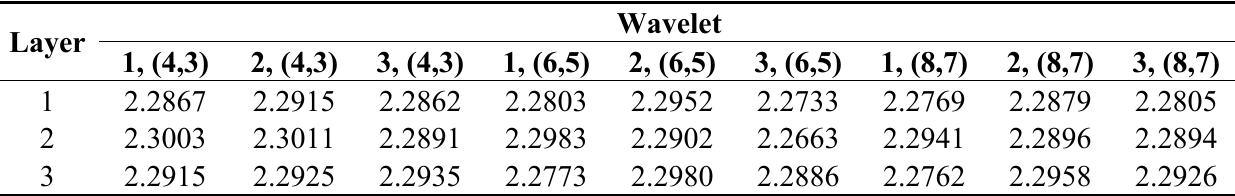
Table 1. Normalized l p norms for node signals at each layer (×10 35